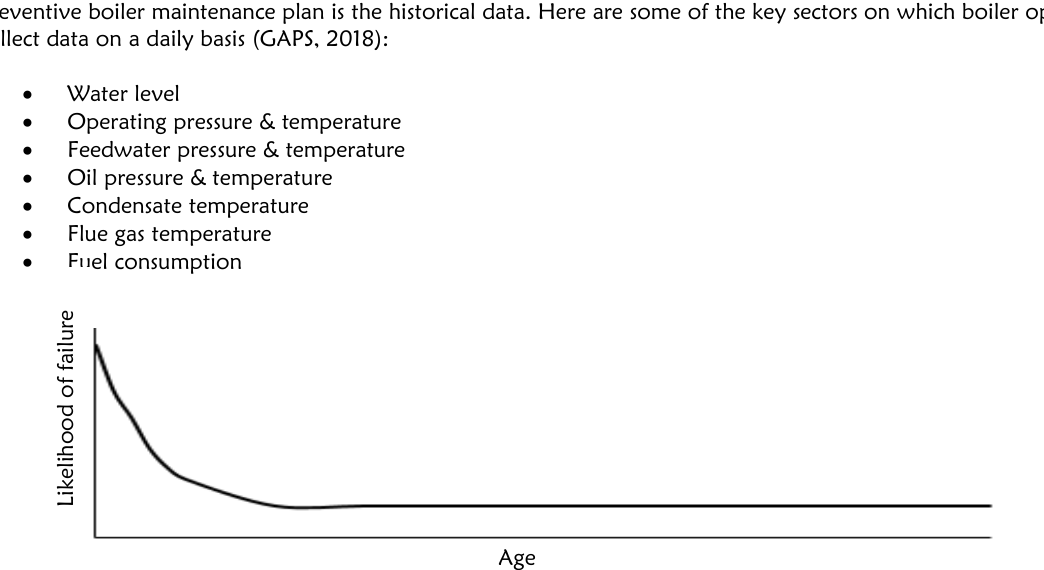
Figure 5: Lifetime likelihood of failure under preventive maintenance (Daley,